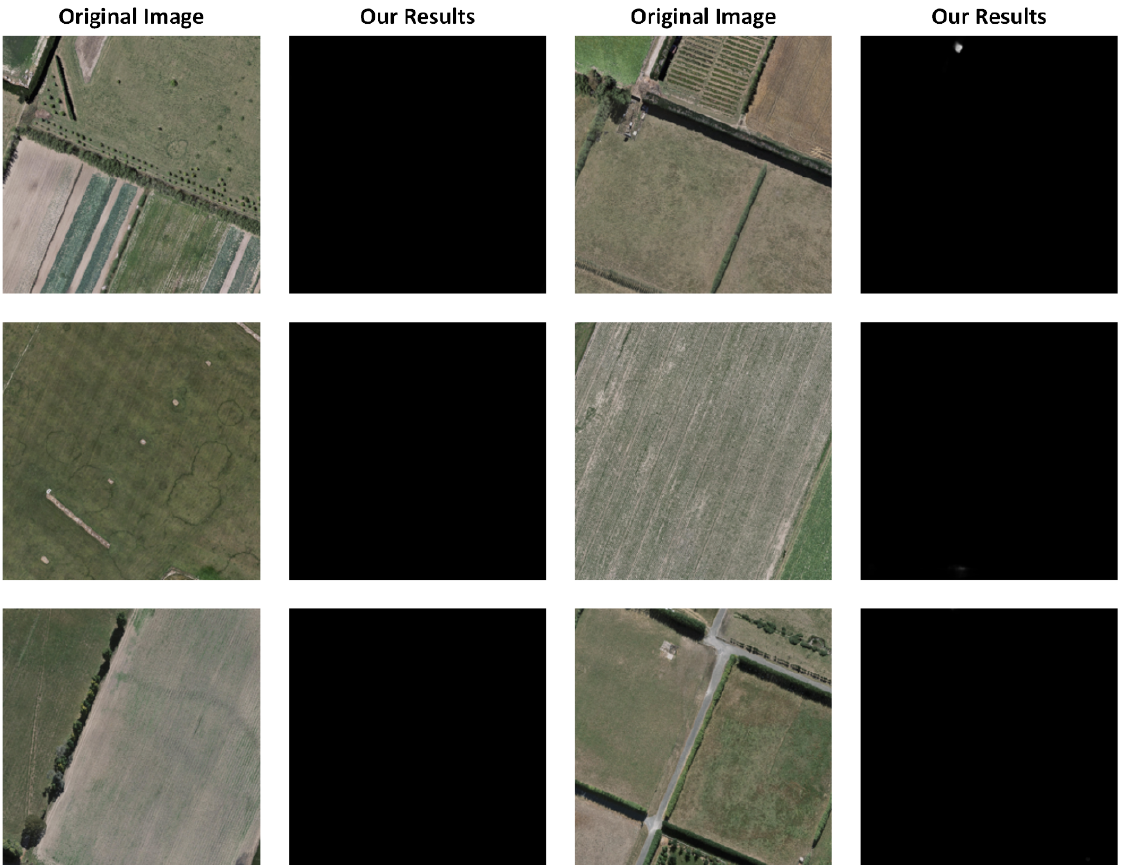
Figure 12. The extraction result exhibitions of images without buildings in the WHU building dataset.